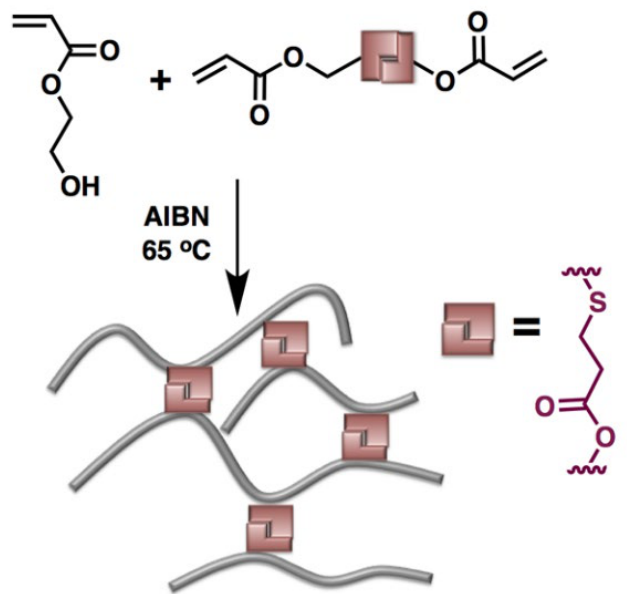
Figure 2. Example of a CAN based on thia-Michael exchange. (Adapted from Ref. [45], copyright 2022, with permission of American Chemical Society).